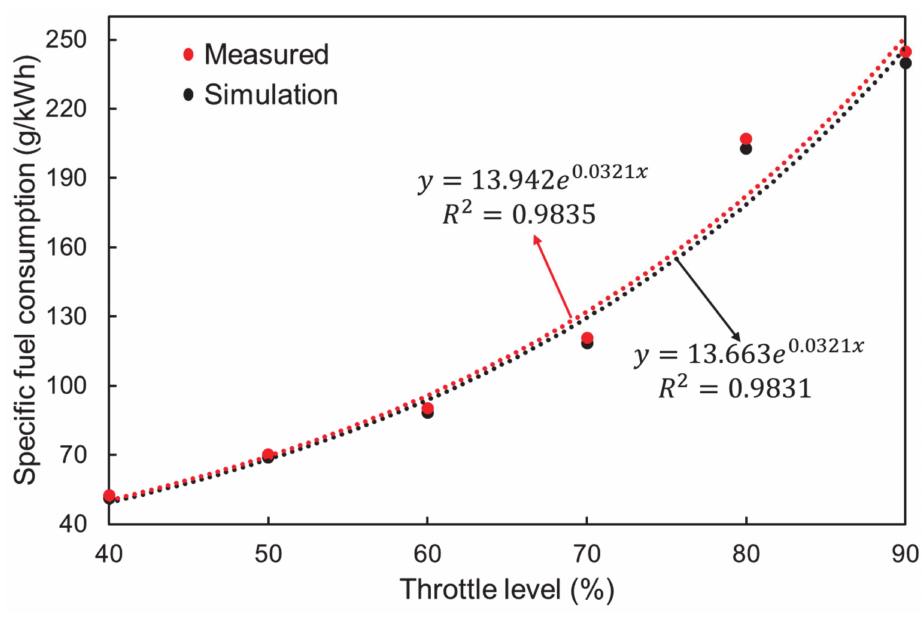
Figure 9. The regression of the average measured and simulation Specific Fuel Consumption (SFC) at various load levels. Table 5. The statistical analysis of both simulation and measured specific fuel consumptions (SFC) at various engine load